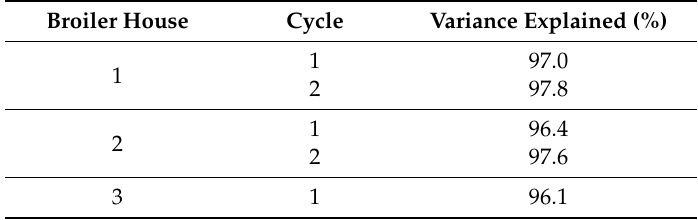
Table 2. Percentages of variances explained by the first two principal components for the cycles in the training